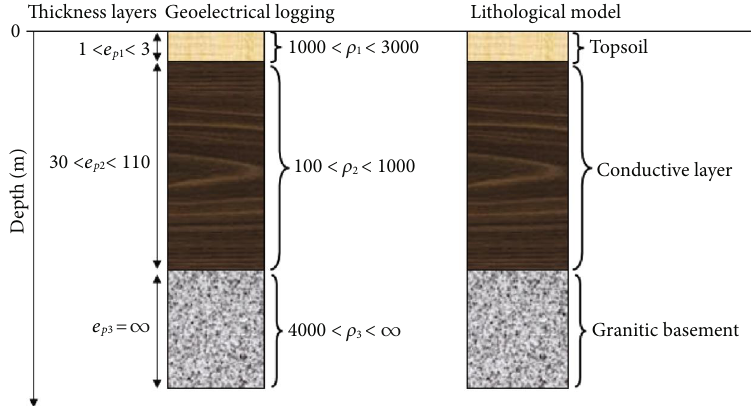
Figure 20: Lithological model of sounding curves of type H.